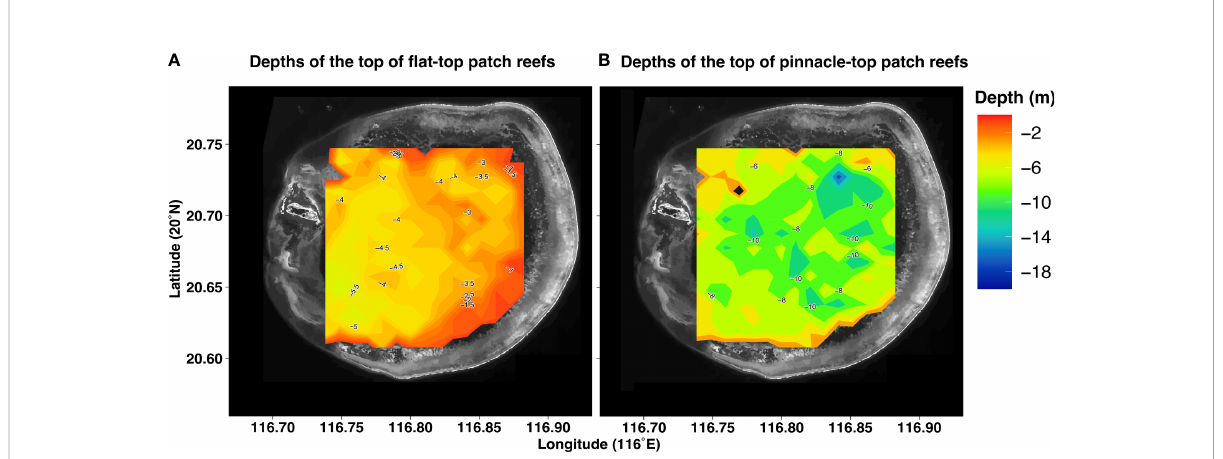
FIGURE 6 Contour maps of the surfaces of patch reefs in the Dongsha Atoll lagoon. Both maps are based on LiDAR images of systematically selected samples from the Dongsha Atoll lagoon. (A) Contour map of the surfaces of fl at-top patch reefs ( n = 208). (B) Contour map of the surfaces of pinnacle-top patch reefs ( n = 206). The dark part is in grayscale of the satellite